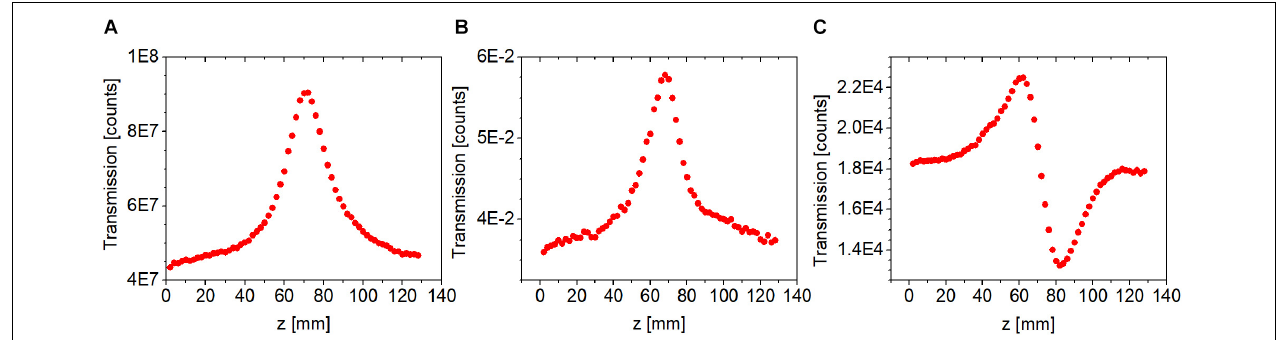
FIGURE 5 | Closed-aperture Z-scan traces measured using fs laser pulses at 514 nm for a bR sample at an average peak intensity of 0.13 W/cm 2 . (A) Uncorrected closed-aperture trace. (B) Corrected closed-aperture trace obtained by dividing the uncorrected closed-aperture trace (cf. A ) by the corresponding open-aperture trace. (C) Corrected closed-aperture trace obtained by applying our novel method described in Section “Procedure for Separating Refractive Nonlinearities in Closed-Aperture Z-Scan Traces.”